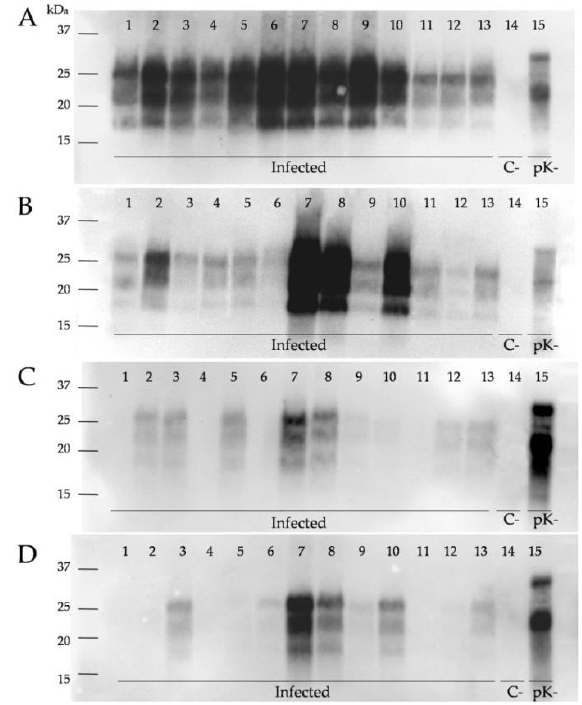
Figure 2. Western blot detection of PrP res in the CNS of control and natural scrapie-infected sheep. Equal protein quantities were loaded for adequate comparison, and immunoblots were run using SHA31 monoclonal antibody for analysis of samples from the ( A ) medulla oblongata, ( B ) thalamus, ( C ) hippocampus, and ( D ) frontal cortex from scrapie-infected sheep with incipient clinical signs (samples 1–5) and with advanced clinical signs (samples 6–13). Line 14 shows the negative control and line 15 a sample of non-infected sheep brain homogenate not subjected to pK digestion.